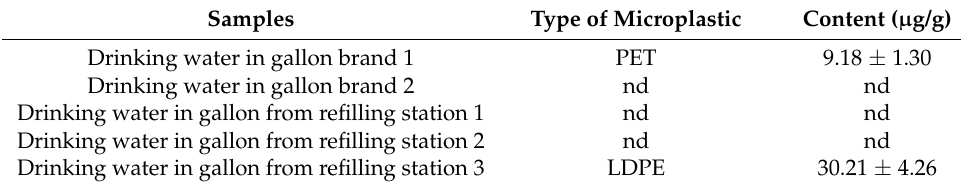
Table 1. Microplastic content in drinking water.